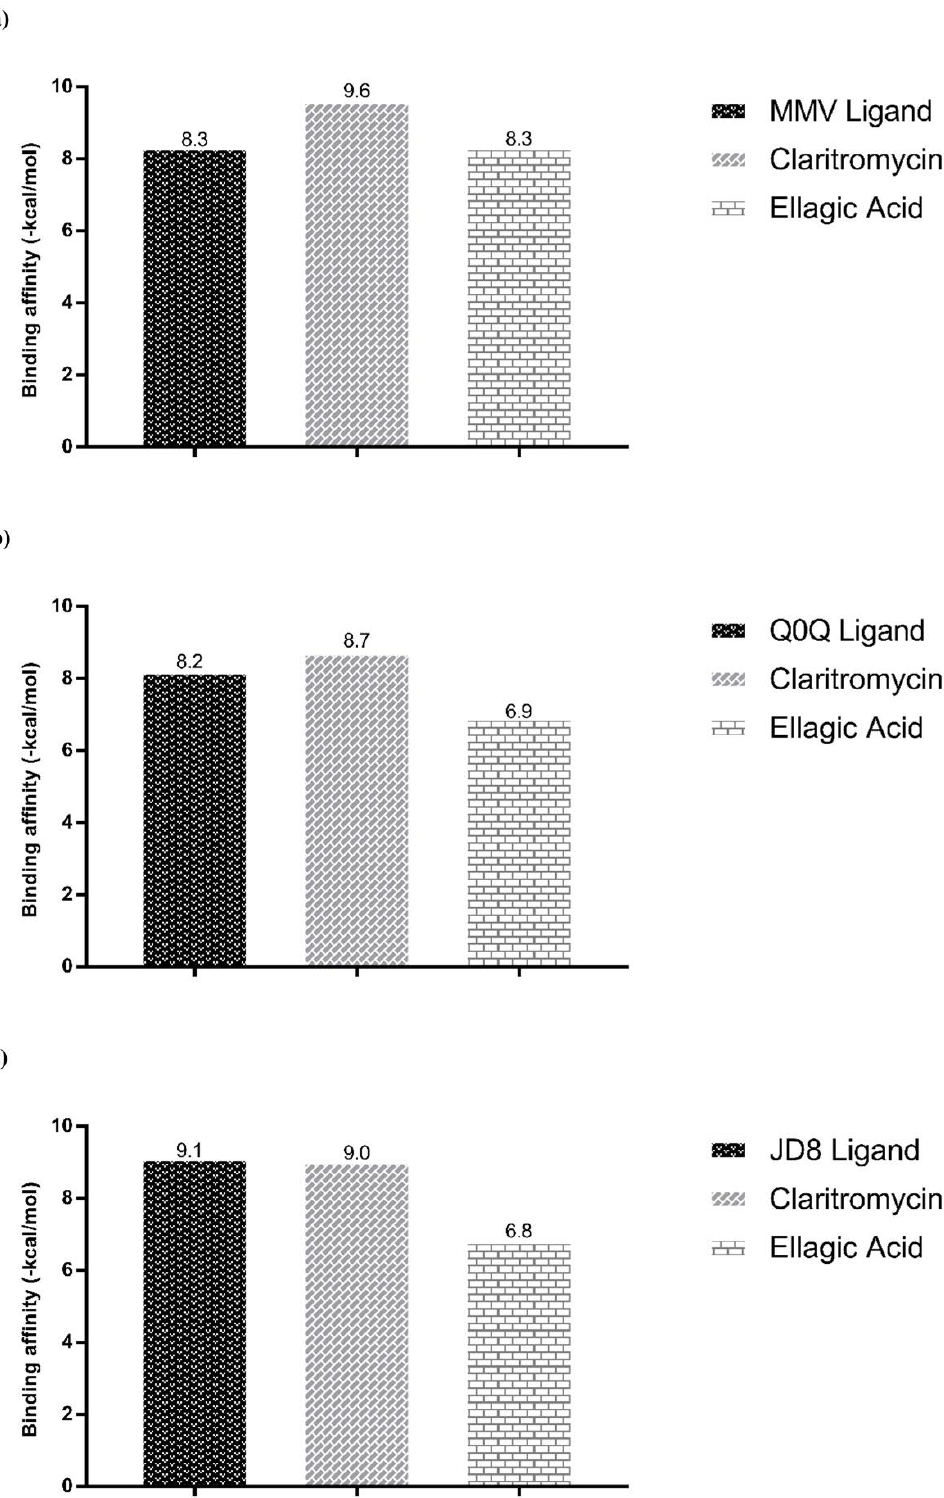
Figure 4. Binding affinity values of the native ligands, clarithromycin, and ellagic acid with targets of antimicrobial activity obtained by molecular docking via Dockthor. The selected targets were: ( a ) Dihydrofolate reductase (PDB ID 7K6C); ( b ) Phosphoribosylaminoimidazole-succinocarboxamide synthase (PDB ID 6YYB), and ( c ) tRNA (guanine-N(1)-)-methyltransferase (PDB ID 6QR4).